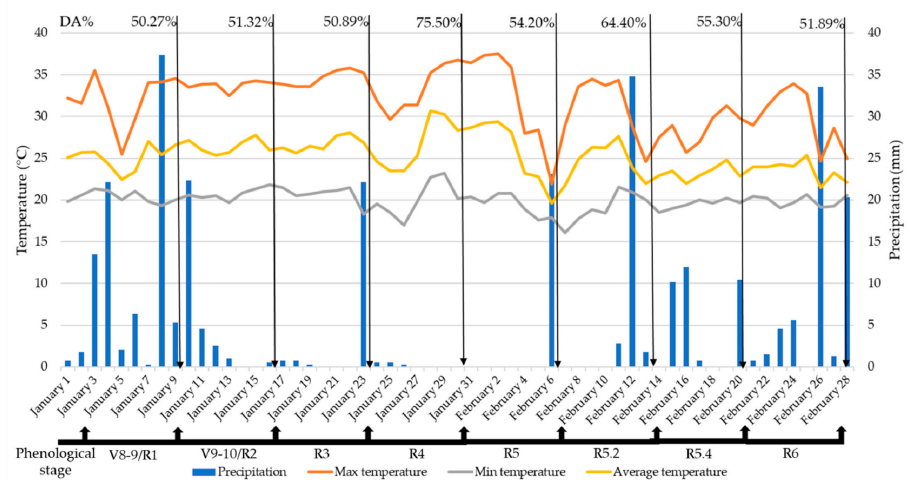
Figure 2. Meteorological data and discriminant analysis (DA) accuracy (%). Letter “V” stands for vegetative stages and “R” for reproductive stages.